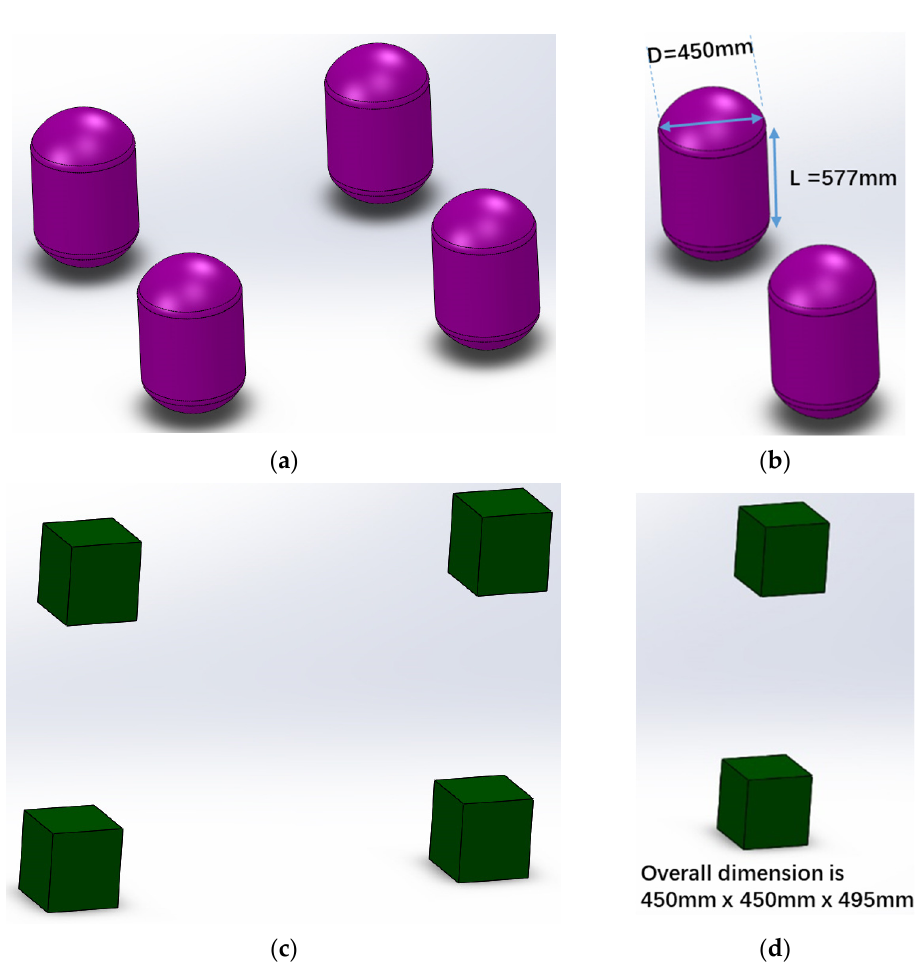
Figure 3. Schematic diagram of propulsion gas cylinder and low temperature lock cabinet: ( a ) original layout of propulsion gas cylinders; ( b ) computable model of propulsion gas cylinders; ( c ) original layout of low temperature lock cabinets; ( d ) computable model of low temperature lock cabinets.